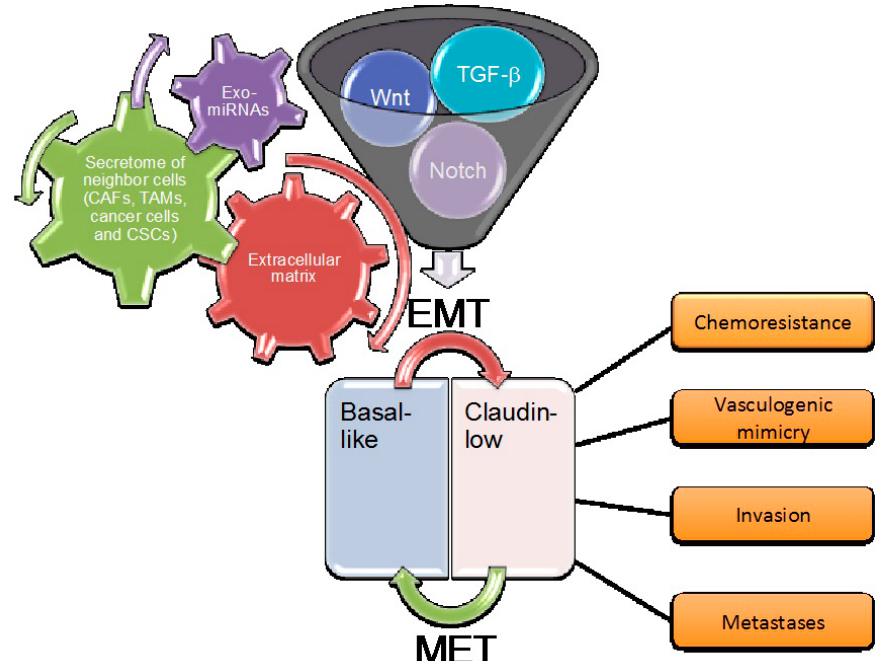
Figure 1. Contributing factors to the claudin-low phenotype and its impact on tumor behavior. The funnel encloses some of the main endogenous pathways involved in the epithelial-to-mesenchymal transition (EMT) process. The gear diagram indicates the various exogenous factors acting in a paracrine way on the endogenous EMT pathways. In the lower part of the scheme, the red upper arrow refers to the origin of claudin-low from basal-like carcinomas, whereas the green lower arrow depicts a possible reversion of the mesenchymal phenotype (mesenchymal-to-epithelial transition (MET) with the re-acquisition of the basal-like features. On the right, in orange, the cell functions resulted enhanced in the claudin-low phenotype as a consequence of the EMT induction.